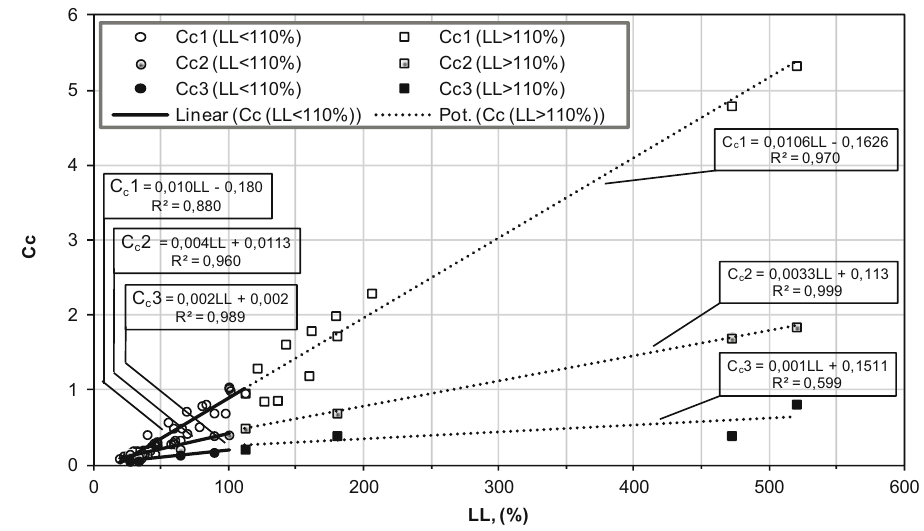
Figure 11: Best - fi t relationship of C c ’ s ( C c1 , C c2 , and C c3 ) vs complete range of